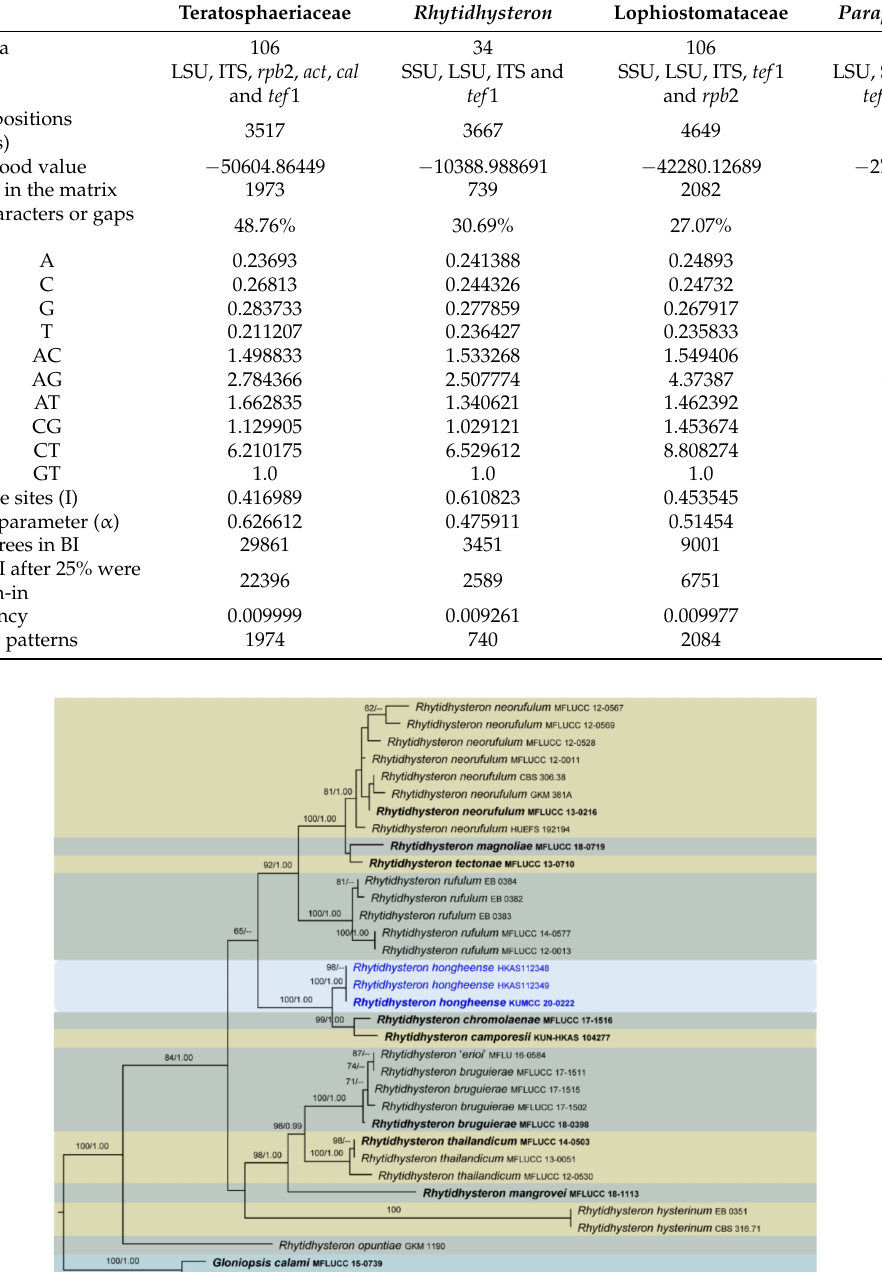
Table 4. Maximum-likelihood (ML) and Bayesian (BI) analyses results for each sequenced dataset.